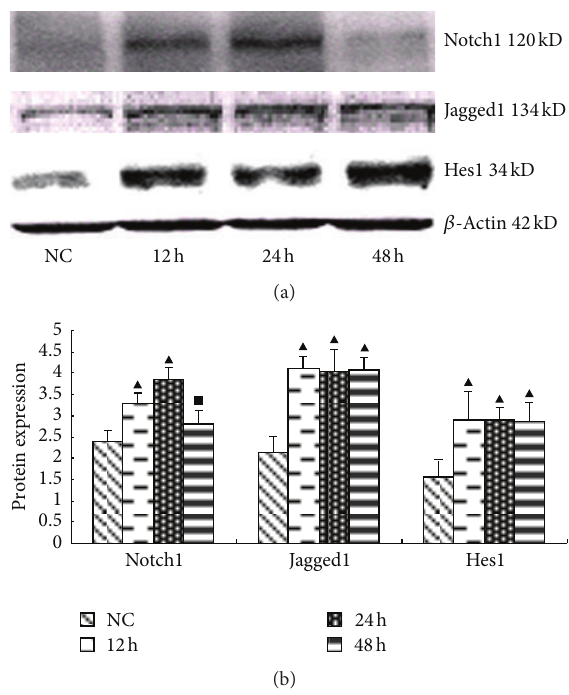
Figure 3: The expression of Notch pathway components in GMCs induced by 25mmol/L glucose at various times determined using Western blot. (a) Western Blot strip chart for different times. At the 24h time point, all Notch-related proteins were significantly enhanced. Notch1 protein was increased at both the 12h and 24 h time points, with the 24h increase being more pronounced. (b) The gray value statistics graph of the protein level. 󳵳 𝑃 < 0.05 versus NC group; ∙ 𝑃 < 0.05 versus 12h group; ◼ 𝑃 < 0.05 versus 24h group.